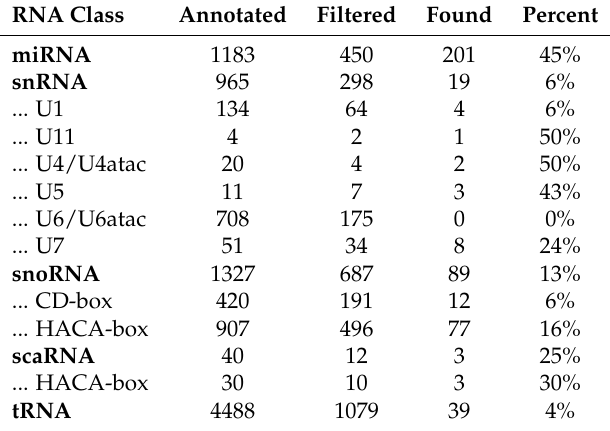
Table 3. Sensitivity analysis. The columns annotated contain the absolute number of annotated transcripts belonging to this class. The column filtered gives the number of transcripts from this group that are at least 80% within a continuous region of the filtered alignment. The column found gives the number of RNAs from the last column that are at least 60% overlapped by a single locus on the strand at which they are annotated. (In addition to the reported numbers, there are a few cases were a locus is only found on the reverse complement of an annotated RNA, or an RNA not 80% inside the filtered alignment is found by our screen). The percent value is calculated based on the columns “found” and “filtered”. miRNA: micro RNA; snRNA: small nuclear RNA, snoRNA: small nucleolar RNA, scaRNA: small Cajal body-specific RNA; tRNA: transfer RNA RNA Class Annotated Filtered Found Percent